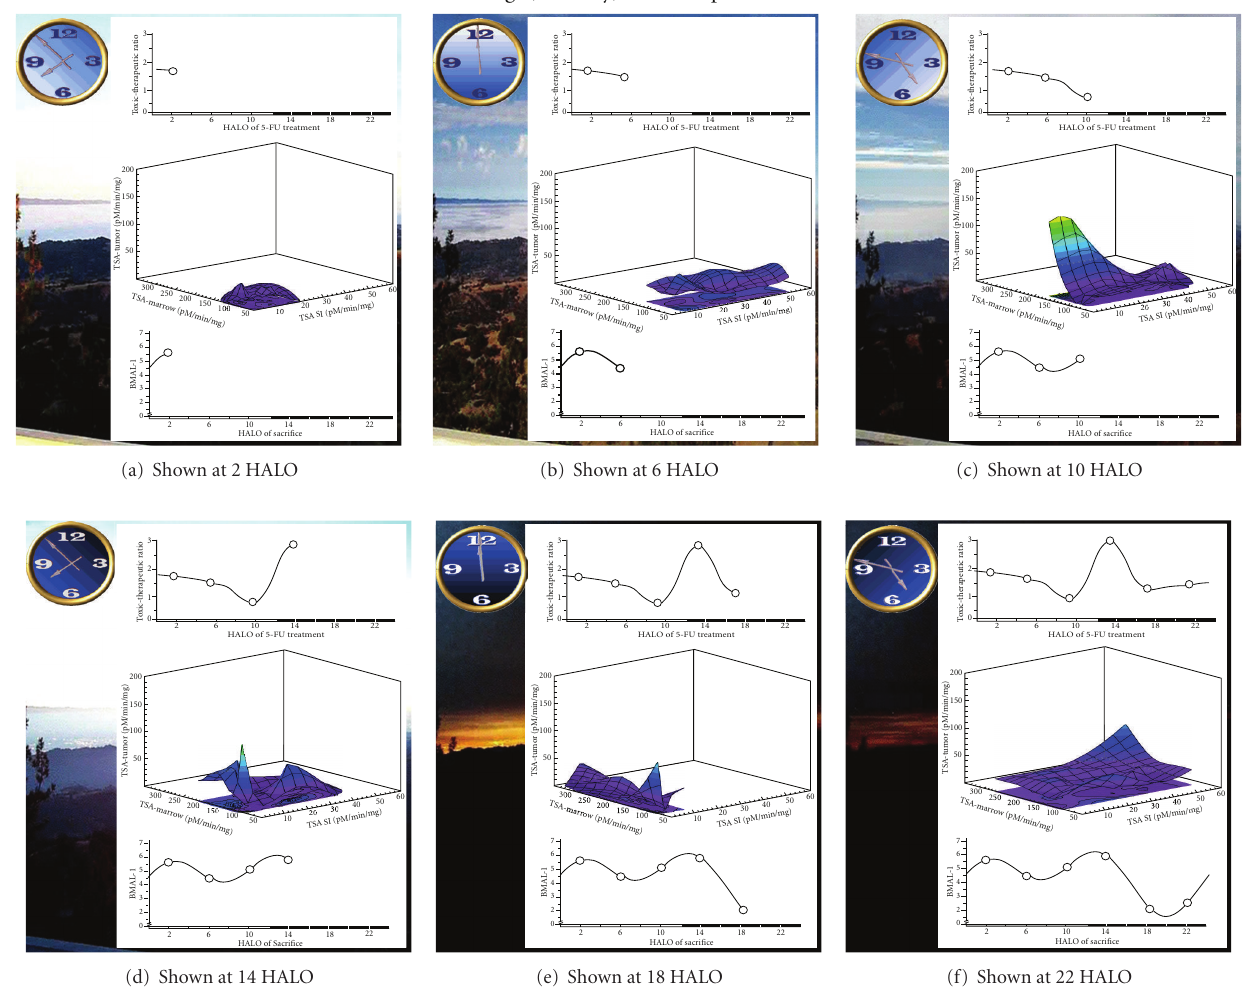
Figure 3: Snapshot of Supplementary Movie 3. The relationship between 5-FU Target and Toxic-Therapeutic ratio proceeds throughout the day indicating time of day association with low tumor thymidylate synthase activity are concurrent with times of day of the greatest anticancer activity. Times of low thymidylate synthase in bone marrow and gut cell are those same times of day associated with the greatest gut damage and bone marrow damage. Toxic-therapeutic ratio is maximum at times of day of relatively low tumor thymidylate synthase activity and relatively high bone marrow and gut